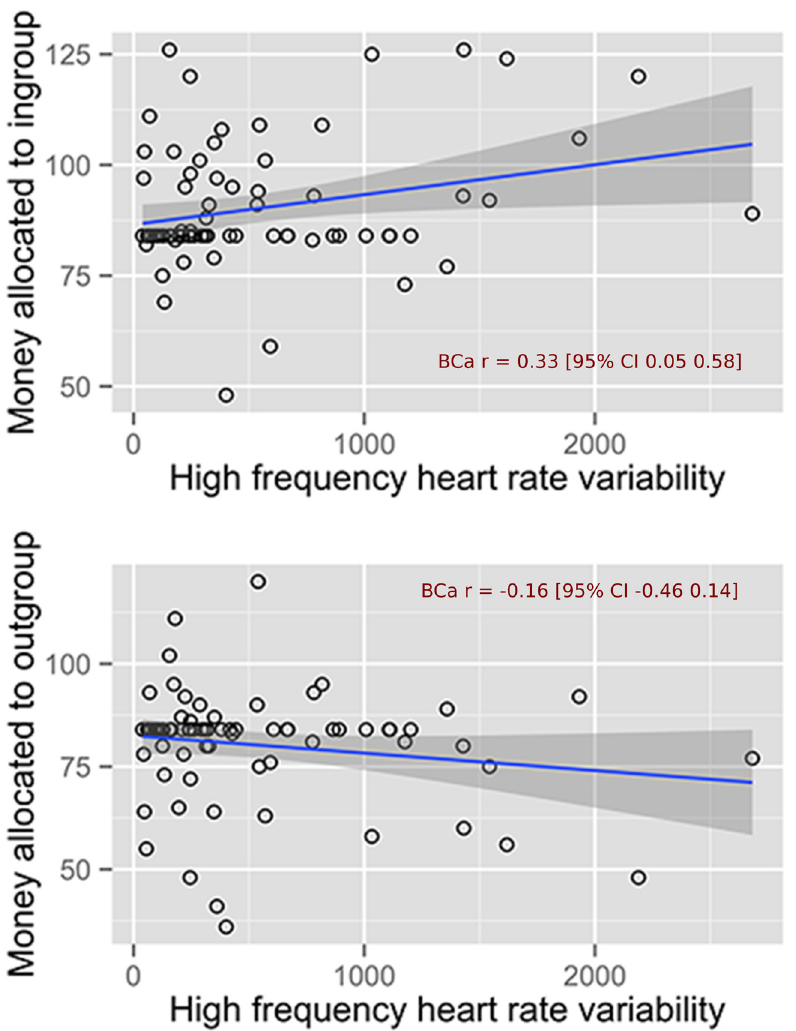
Fig 1. Scatterplots with lines of best fit and 95% confidence internals demonstrating the association between mean HF-HRV and money allocation to the ingroup (top panel) and the outgroup (bottom